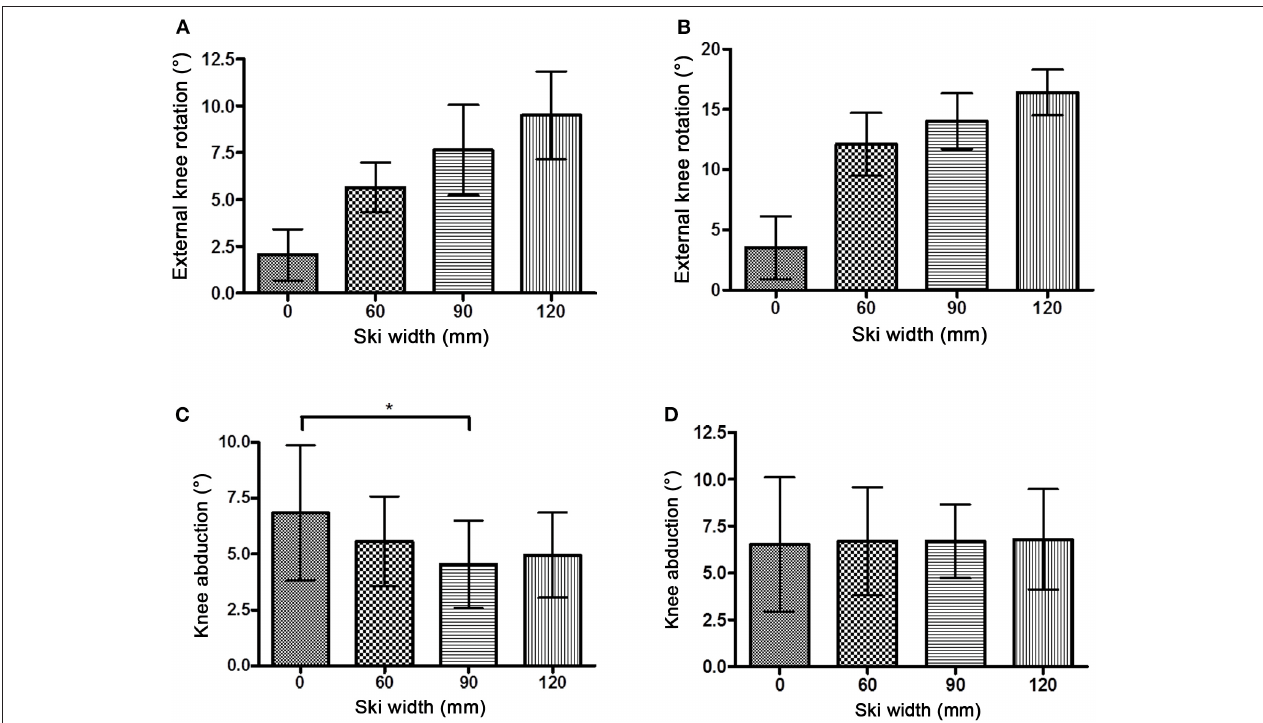
FIGURE 4 | External knee rotation (mean ± SD) with knee flexion 40 ◦ (A) and 60 ◦ (B) . A statistical significant increment of the external rotation was observed with each increase in the ski waist width in both knee flexion settings. Knee abduction/valgus (mean ± SD) with knee flexion 40 ◦ (C) and 60 ◦ (D) . The statistically significant difference for abduction is marked with